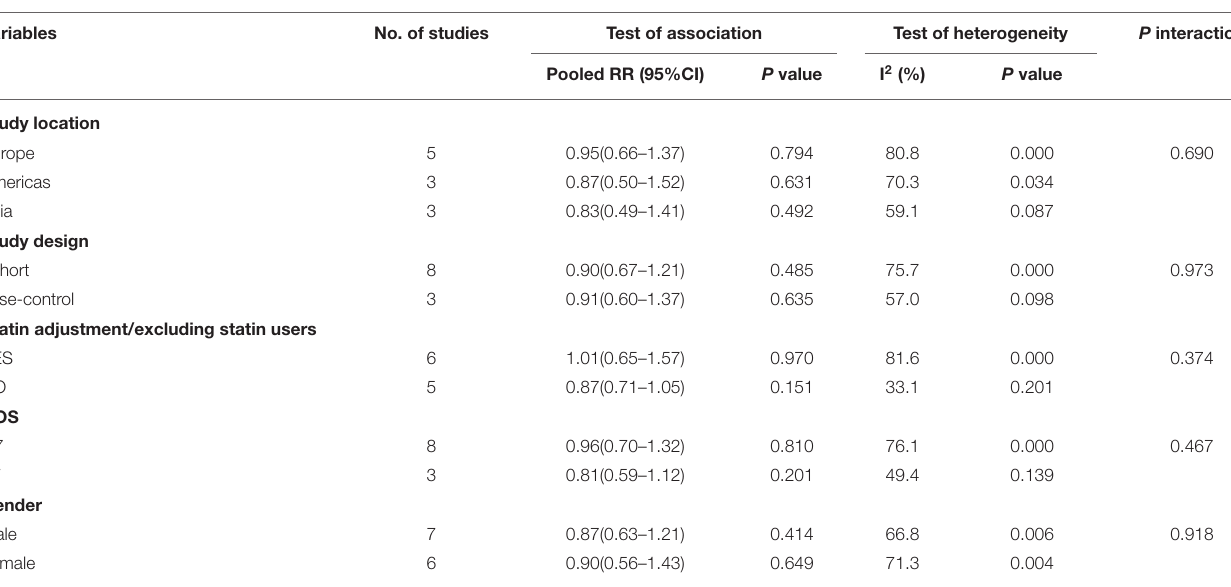
TABLE 2 | Subgroup analyses (serum TC levels and PD